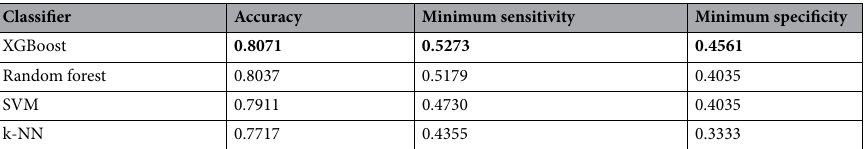
Table 7. Comparison of the proposed method with other classifiers in the test cohort. The bold values indicate the highest score in each performance metric. SVM support vector machine, k-NN k-nearest